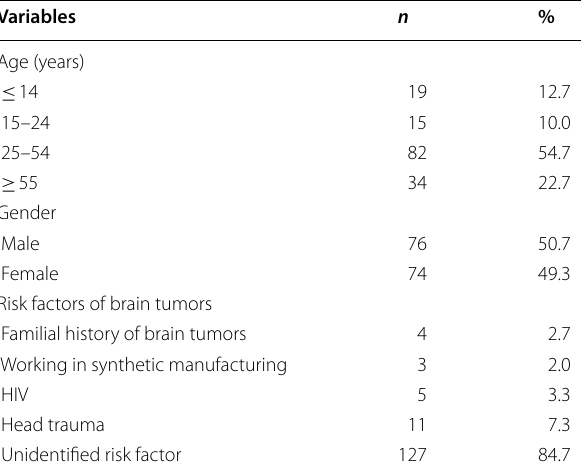
Table 1 General characteristics of the study